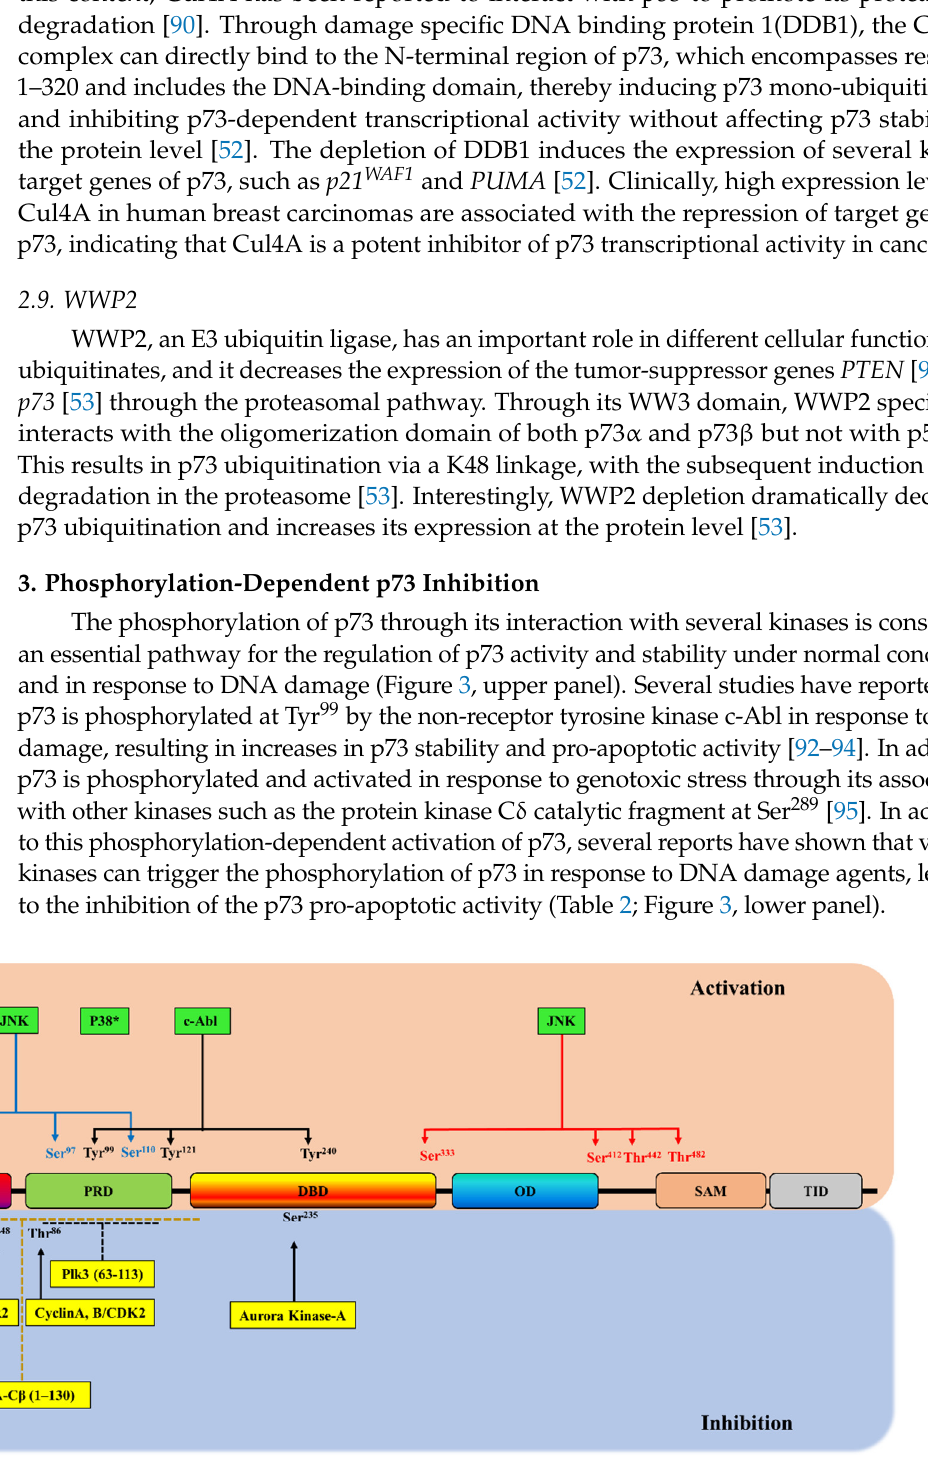
Figure 3. Positions of phosphorylation sites on TAp73 α . Upper panel: phosphorylation-dependent activation of TAp73 α and its phosphorylation sites. Lower panel: phosphorylation-dependent inhibition of TAp73 α . * indicates that the p73 phosphorylation site is unknown.